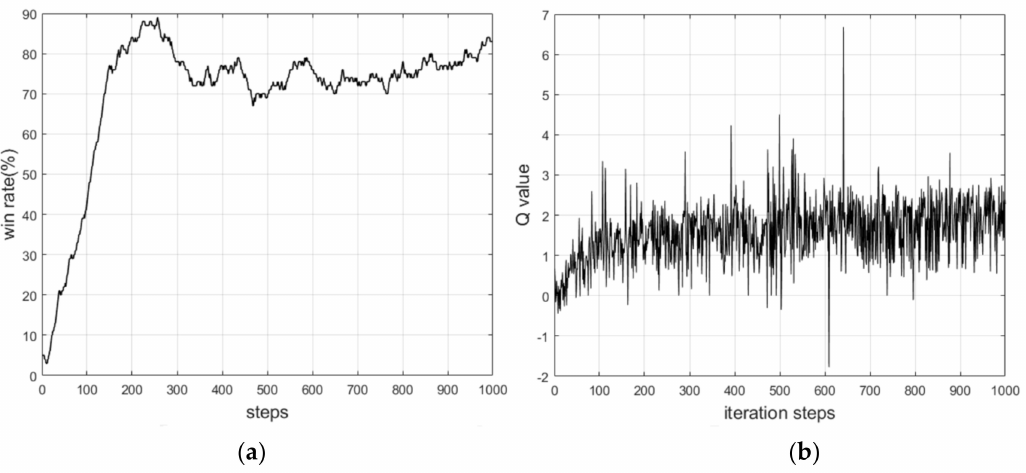
Figure 4. ( a ) Win rate; ( b ) The average Q